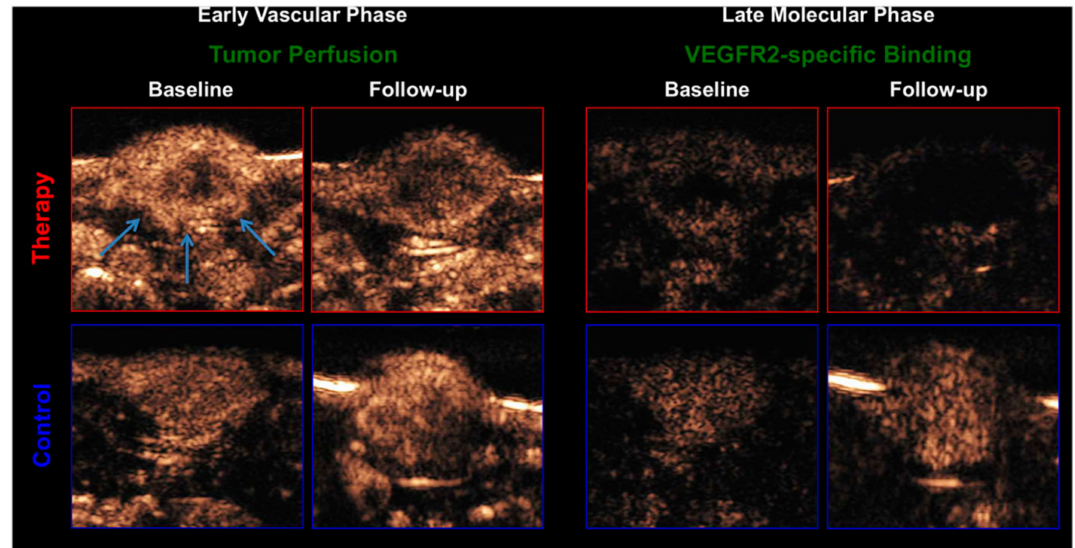
Figure 5. CEUS images of treated (top) and untreated tumors (bottom). Left side: early vascular phase with VEGFR2-targeted MB as a functional imaging biomarker; Right side: late phase of VEGFR2-specific binding with the targeted MB as a molecular imaging biomarker 8 min after contrast injection. Reproduced with permission from [51]. Copyright Eschbach et al.,